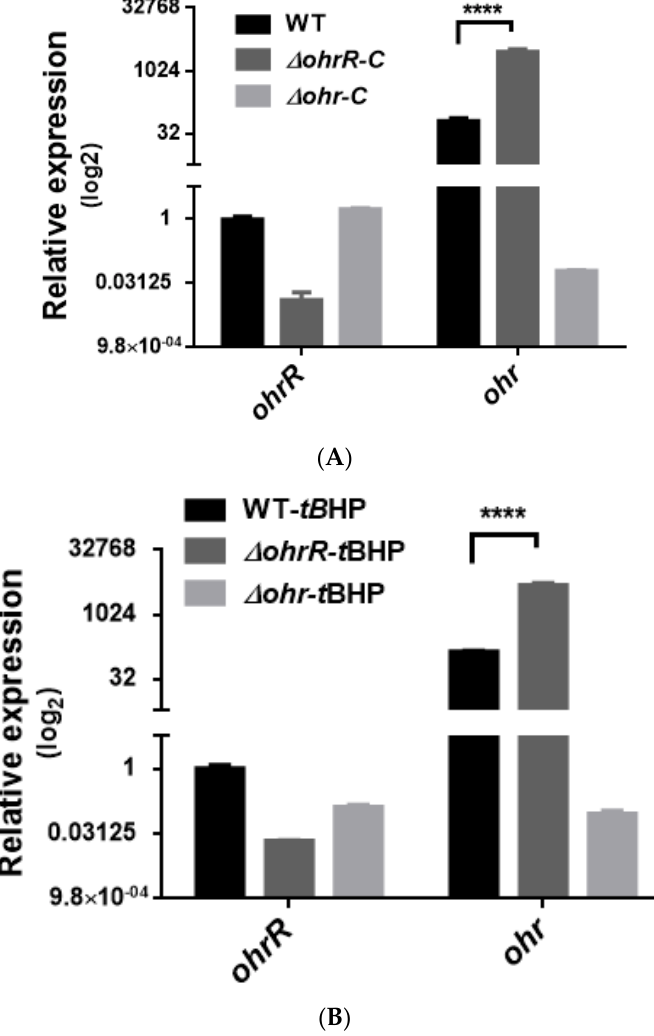
Figure 5. Transcriptional expression of chromosomal ohrR-C-ohr-C genes in different strains of A. baumannii ATCC 17978, as quantified by qRT-PCR. Relative expression of chromosomal ohrR-C-ohr-C genes in ohrR-C mutant ( ∆ ohrR-C ) and ohr-C mutant ( ∆ ohr-C ) strains compared with wild-type strains in the absence ( A ) and presence of 200 μ M of t BHP for 20 min ( B ). Each sample was normalized using gyrase gene expression as an internal control. The expression of ohrR-C gene in wild type was determined as 1 for comparison. These data were obtained from three independent experiments. Multiple-way ANOVA was used to determine the significance of each phase. **** indicates p < 0.0001.